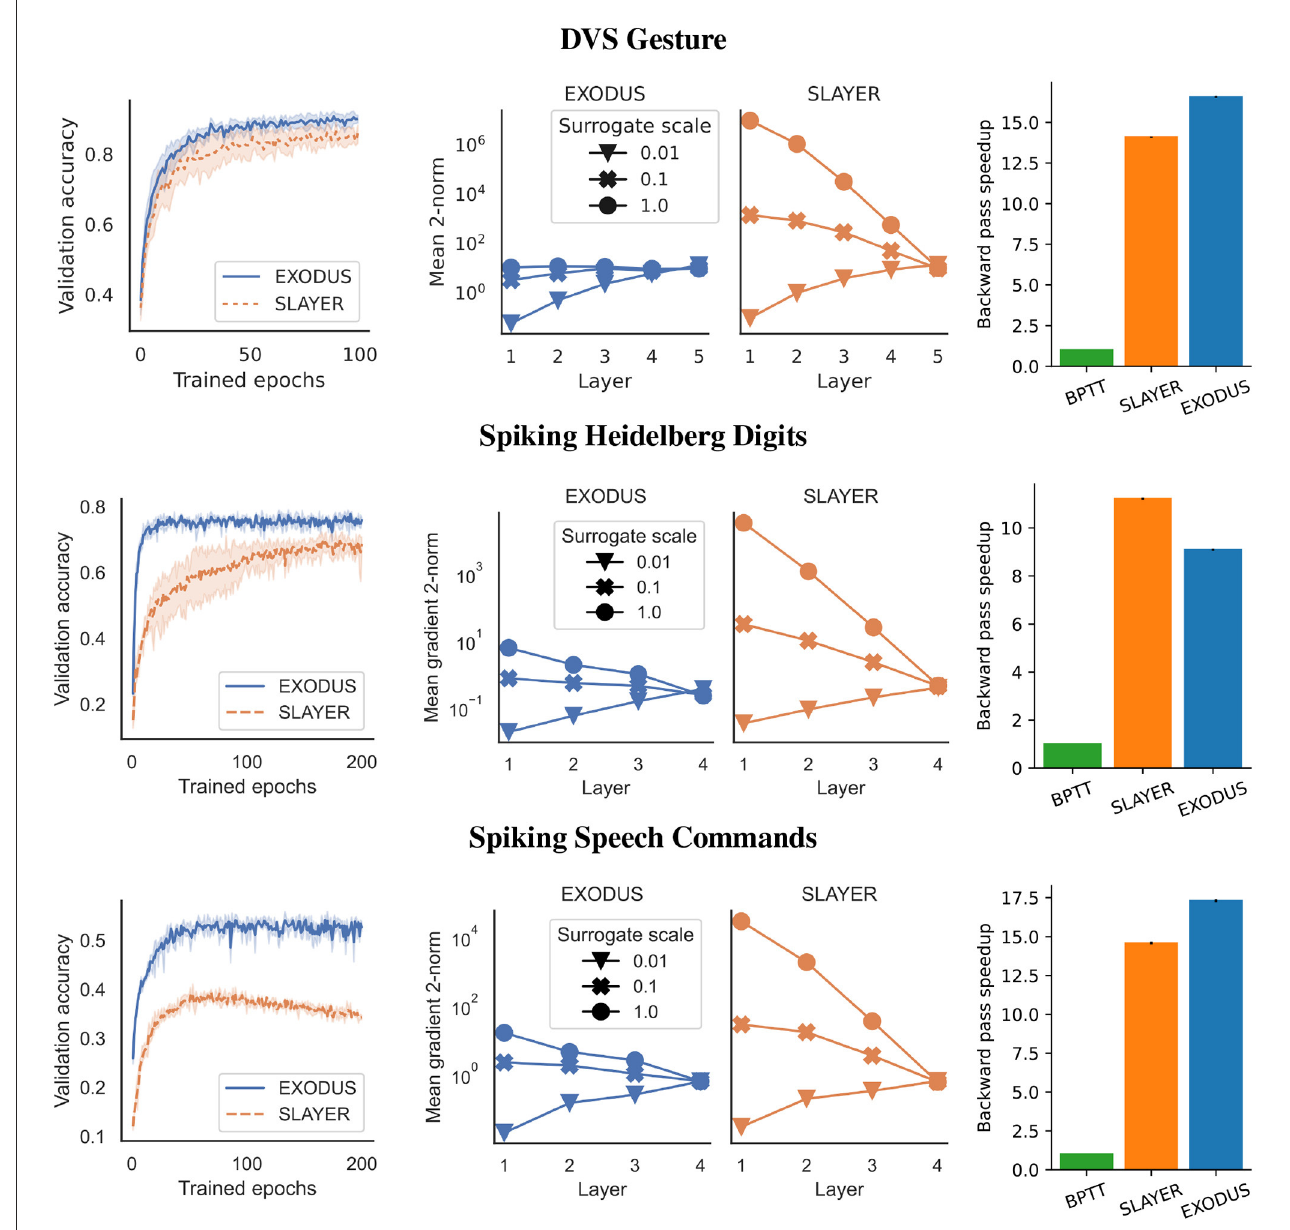
FIGURE2 Performance on DVS Gesture (Top row) with 5-layer architecture, Spiking Heidelberg Digits (Center row) and Spiking Speech Commands (Bottom row) datasets. (Left column) Validation accuracy averaged over three runs for each algorithm using a gradient scale of 1. EXODUS (solid blue curves) generally converges much faster and reaches a higher accuracy than SLAYER (dashed orange curves), in particular for tasks with strong temporal dependencies. (Center column) Mean two-norms of weight gradients during training, for individual layers and different scaling of surrogate gradient. When surrogate gradients are not down-scaled, gradients for SLAYER explode toward the input layer, whereas for EXODUS they remain mostly stable. Only for very low scaling, gradients vanish for both algorithms. (Right column) Backward pass speedup relative to BPTT. EXODUS is the fastest on average across the three